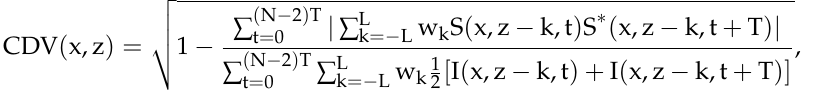
Figure 9. OCTA of the skin on a pig ear. OCT cross-sectional intensity image ( A ) and angiogram ( B ) determined by complex subtraction. ( C ) Overlay of superficial vessels in the epidermis (red) with deeper vasculature in the dermis (green). ( D – I ) Maximum intensity projections centered at different axial (z) positions relative to the surface. In 2014, Nam et al. [63] proposed a complex differential variance (CDV) algorithm. This differential variance algorithm, applied to the OCT signal at a position (x,z), is: CDV(x,z)= (cid:3496) 1- ∑